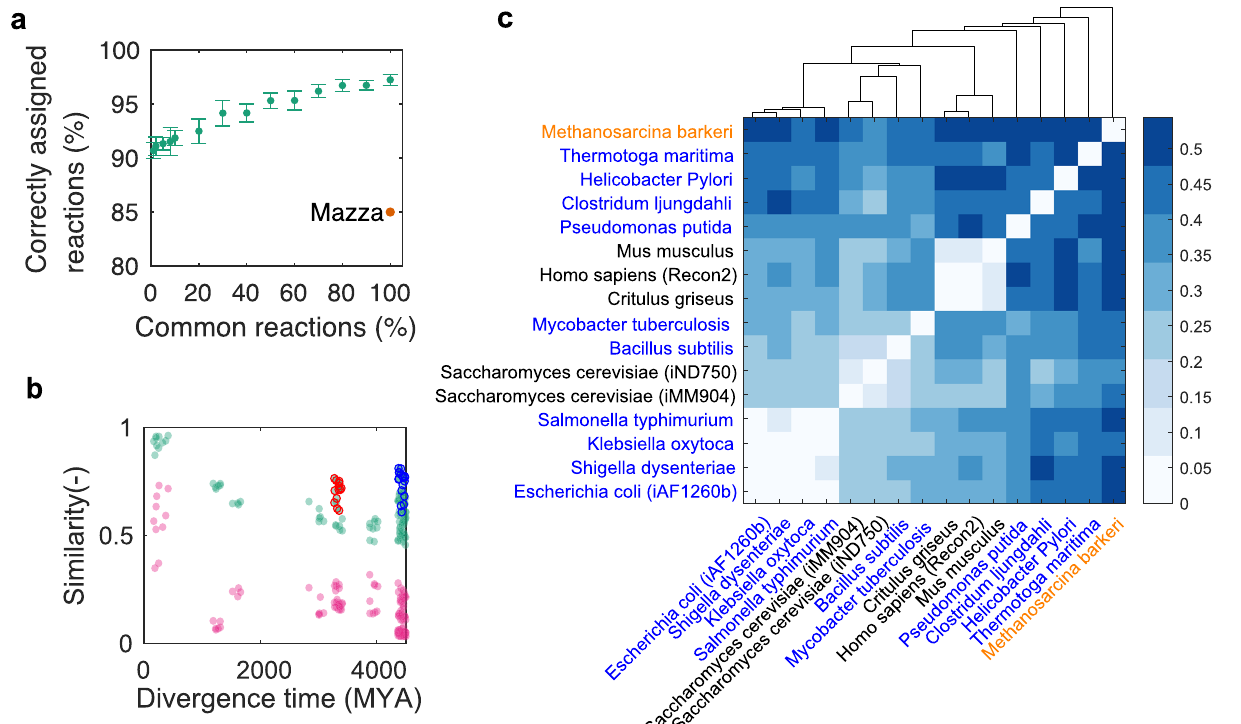
Fig. 3 | Phylogenetic analysis. a Alignment of the yeast GSM iMM904 with itself using variable numbers of common reactions. Green: average ± s.d.; red: method by Mazza et al. 25 b Average sensitivity correlations (Pearson, green) and Jaccard indices (pink) for model pairs as a function of divergence time. Red circles: comparisons between a subset of the Gram-positive bacteria ( B. subtilis and